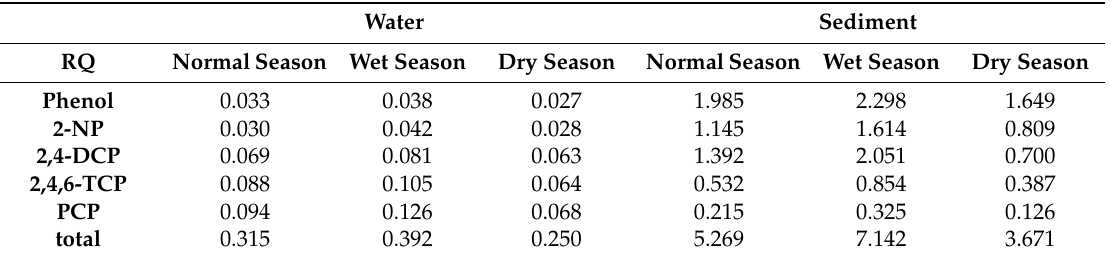
Table 2. The risk quotient values of five phenolic compounds in the Yinma River Basin.